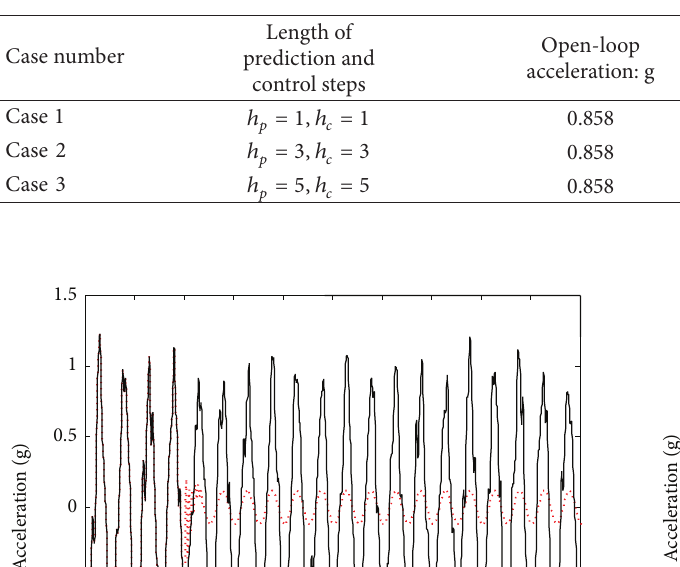
Table 2: Alleviation result for different length of prediction steps.